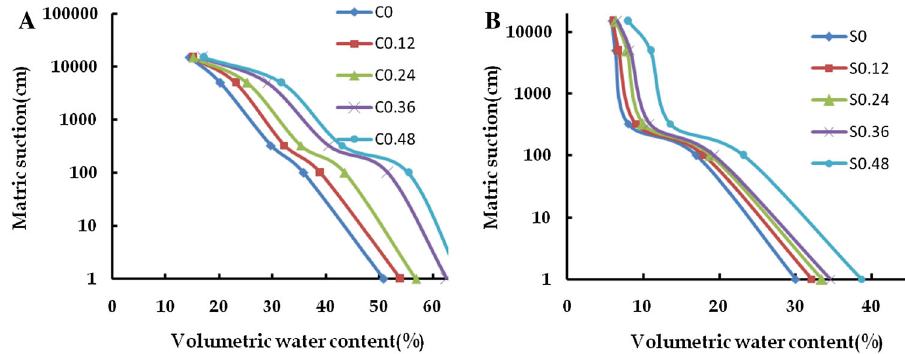
Fig. 1 Soil retention curves of silty clay ( a ) and loamy sand ( b ) soils as affected by different